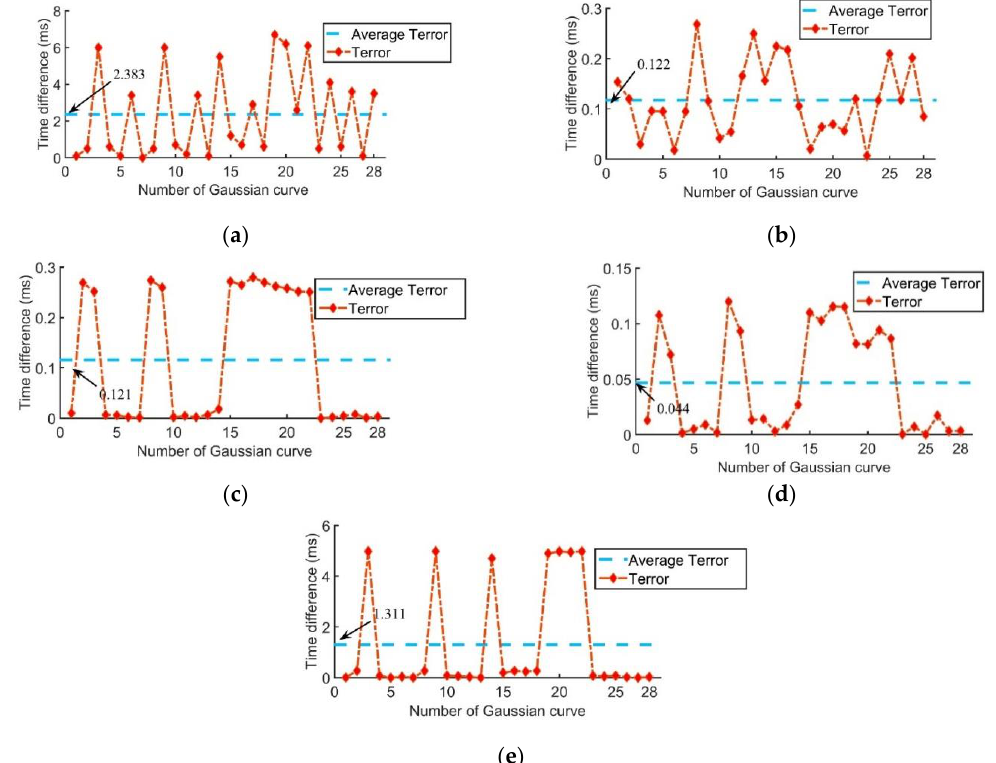
Figure 14. Terror with different filter frequency bands: ( a ) 20–100 kHz; ( b ) 100–200 kHz; ( c ) 200–300 kHz; ( d ) 300–400 kHz; ( e ) 400–500 kHz.